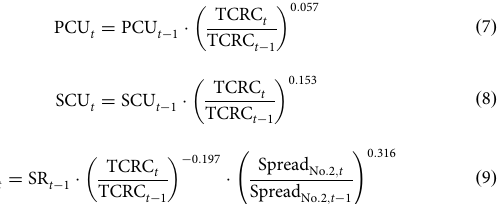
collection rates and technical recycling ef fi ciencies were applied to calculate the useable scrap generated in China and RoW. These values are given in Supplementary Table 7. Global re fi nery production was previously modeled as two individual re fi neries representing primary and secondary re fi neries, where primary re fi neries consume only primary material and secondary re fi neries consume some fraction of secondary material. In secondary re fi neries, the SR describes the secondary fraction of total raw material consumed. In regionalizing re fi nery production, the two representative re fi neries were further split to emulate China and RoW primary and secondary re fi nery production. Each re fi nery ’ s capacity evolved as a function of regional copper cathode demand, with long-run capacity elasticity to demand remaining the prior global value. Similarly, primary and secondary re fi nery CU elasticities to TCRC, as well as SR elasticities to TCRC and No.2 scrap spread, retained their global values. Initial values for regional primary and secondary CU and SR were estimated based on individual re fi nery data from Wood Mackenzie grouped by region, and re fi nery capacity was calculated such that each representative re fi nery ’ s production matched 2018 regional production values based on these parameters. These methods are further elaborated in Supplementary Methods: Regional data and evolution. Re fi nery raw material consumption was calculated assuming concentrate to cathode and No.2 scrap to cathode ef fi ciencies of 99%. Regional cathode consumption was calculated using the combined blending model described below. Copper-based product fabrication . As in the previous, less granular model, global copper demand is estimated as the product of regional (China, EU, Japan,